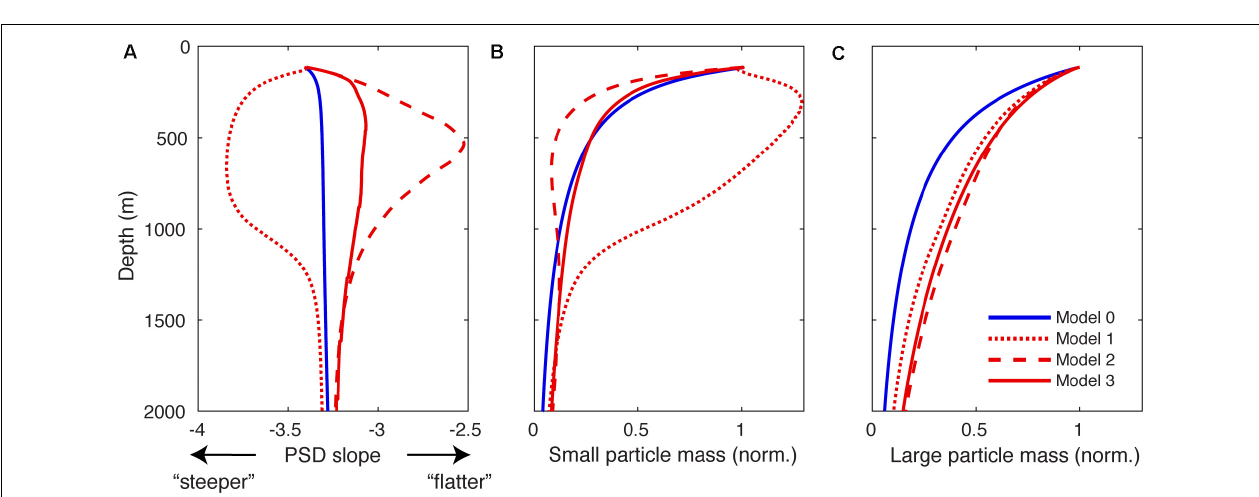
FIGURE 5 | Summary statistics of simulated particle spectra. (A) , Slope of the particle spectrum as a function of depth predicted by Model 0 in the TP region and by Models 1–3 in the ETNP region, derived by fitting a straight line through the simulated spectrum at each model depth horizon. More negative numbers indicate a “steeper” spectrum that is more dominated by small particles, and less negative numbers indicate a “flatter” spectrum that is more dominated by large particles. (B) Mass of particulate organic matter (POM) integrated across small particle size classes, defined here as < 0.5 mm, and normalized to the mass at 100 m. (C) Same as (B) but for large aggregate particles > 0.5